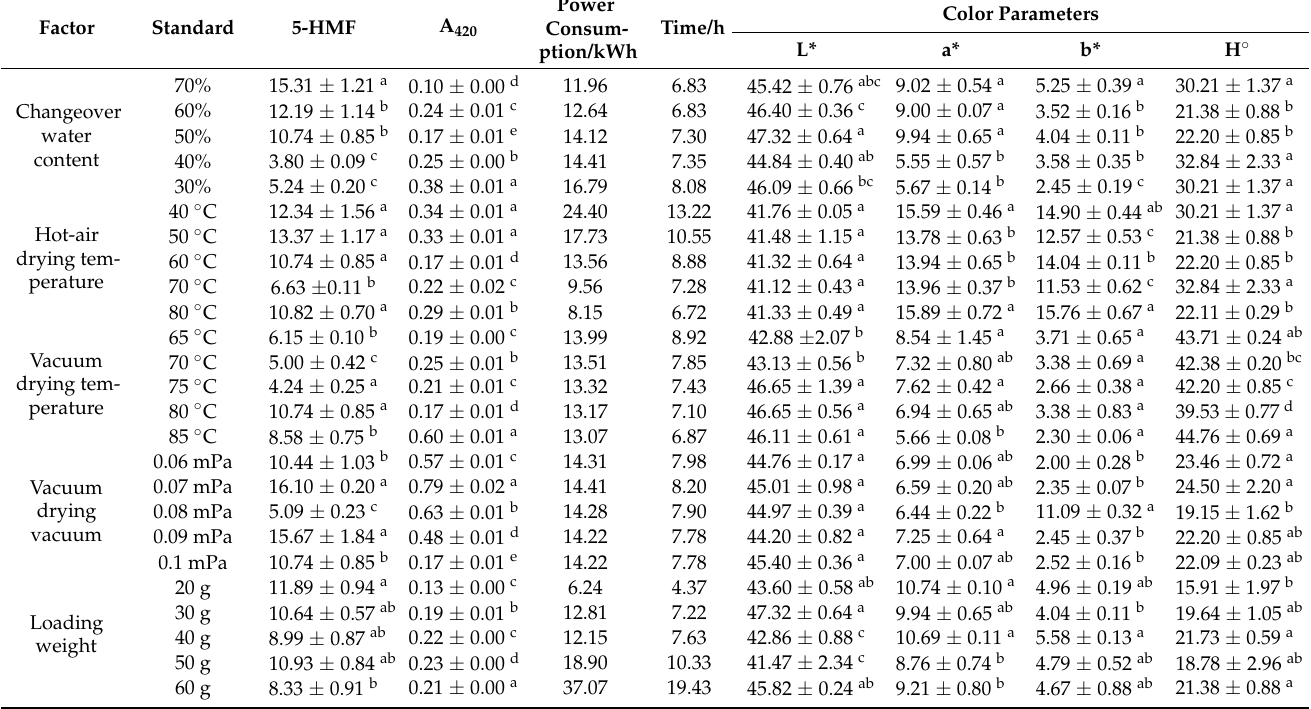
Table A4. The 5-HMF, A420, power consumption, drying time and color parameters of tomato